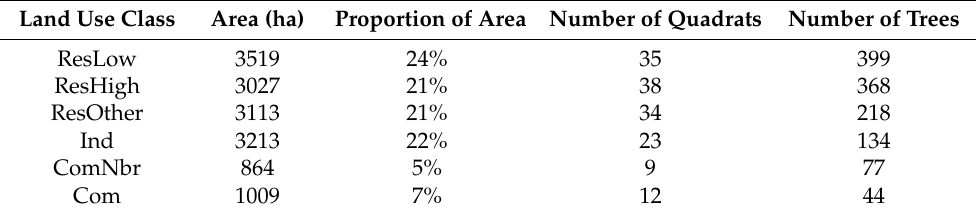
Figure 1. Land use of Kyoto City and distribution of quadrats (mapping under WGS 1984). Table 1. Sample quadrats by stratified sampling method in this research. Land Use Class Area (ha) Proportion of Area Number of Quadrats Number of